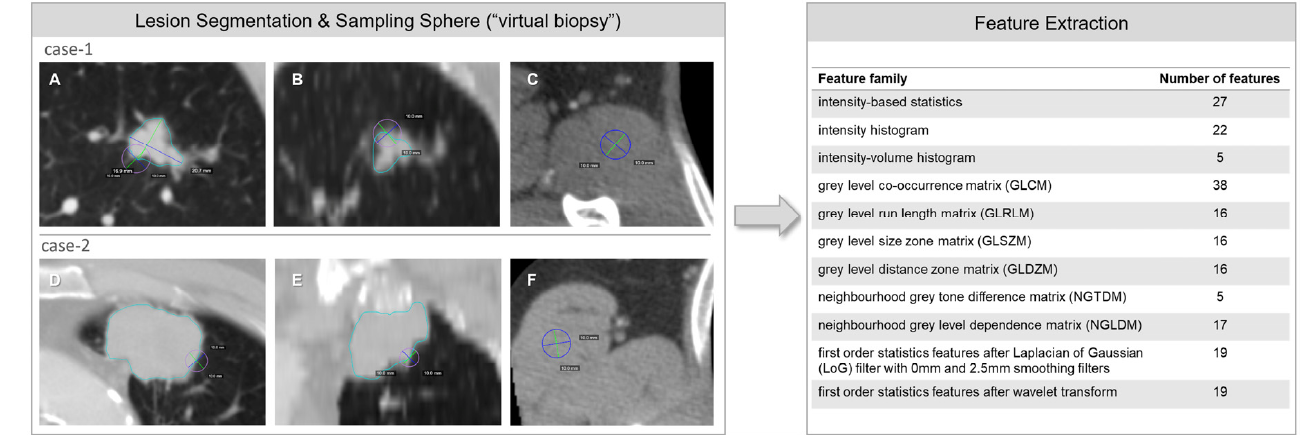
Figure 1. Description of radiomic features extraction. On the left, examples of volumes of interest delineated on the CT images: the light blue line represents the contour of the lesion volume (( A , D ) on the axial plane, ( B , E ) on the coronal plane), the purple line represents the sampling spheres (“virtual biopsy”) centered on the boundary between tumor and peritumoral components (( A , D ) on the axial plane, ( B , E ) on the coronal plane), and the blue line represents the sampling sphere within the muscle tissue ( C , F ). The two rows represent two different patients. The table on the right shows the list of families and the number of the extracted radiomic features for each